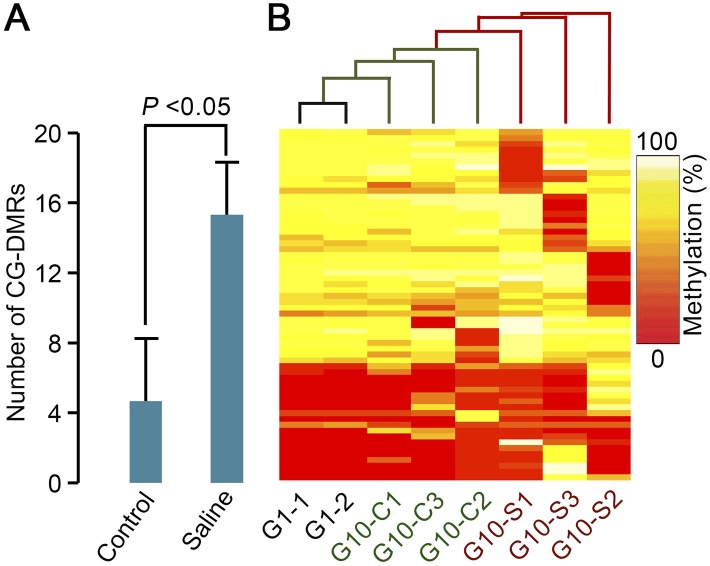
Multigenerational propagation on saline soil increases the accumulation of regional clusters of differentially methylated CG positions (CG-DMRs). (A) Comparison of the number of regional clusters of differentially methylated CG positions (CG-DMRs) (as defined in Methods) identified in saline soil (Saline) and control G10 plant genome samples. Results shown are means ±SD. (B) Hierarchical clustering of samples based on identified CG-DMRs.